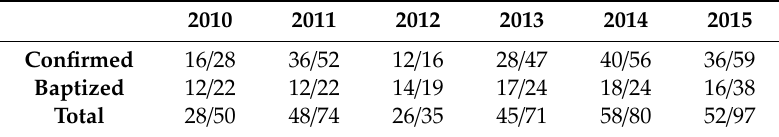
Table 3. YABs at Seoul Anglican